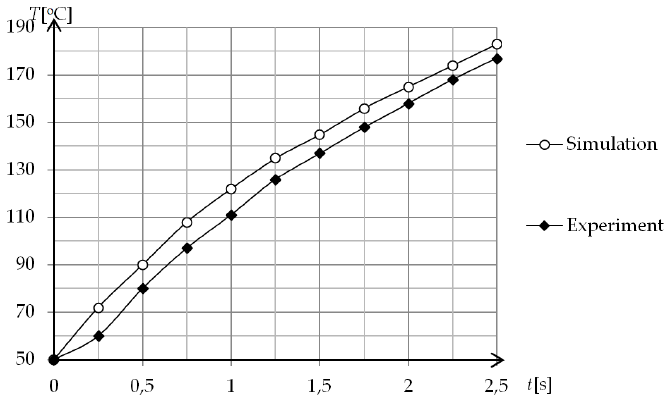
Figure 14. Comparison of numerical and experimental results for induction heating with hollow rectangular coil.